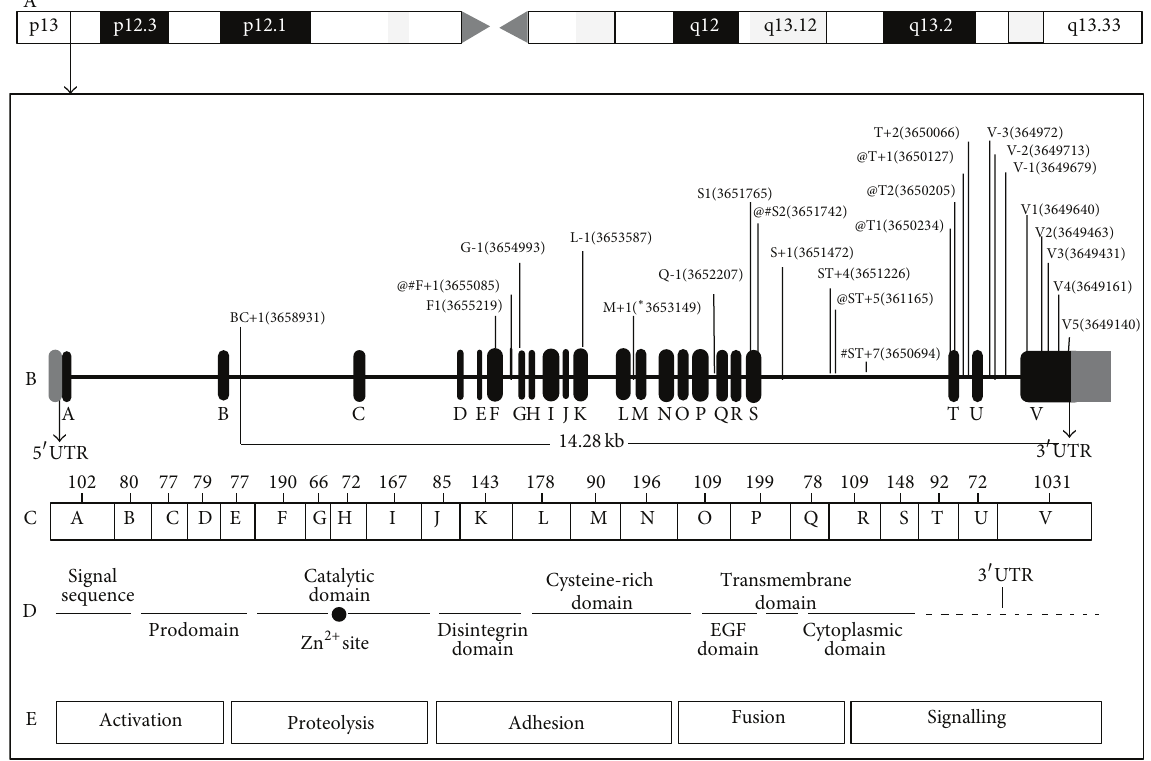
Figure 1: Schematic representation of the ADAM33 gene on chromosome 20. (a) Chromosome 20 showing ADAM33 gene position on 20p13. (b) Region covered by all most common studied polymorphisms by study groups in worldwide population and covered size in Kb. (c) Exons and size in base pairs. (d) Domain structure. (e) Functions of ADAM33 domain. @ represents positive association among Asians; # represents positive association among